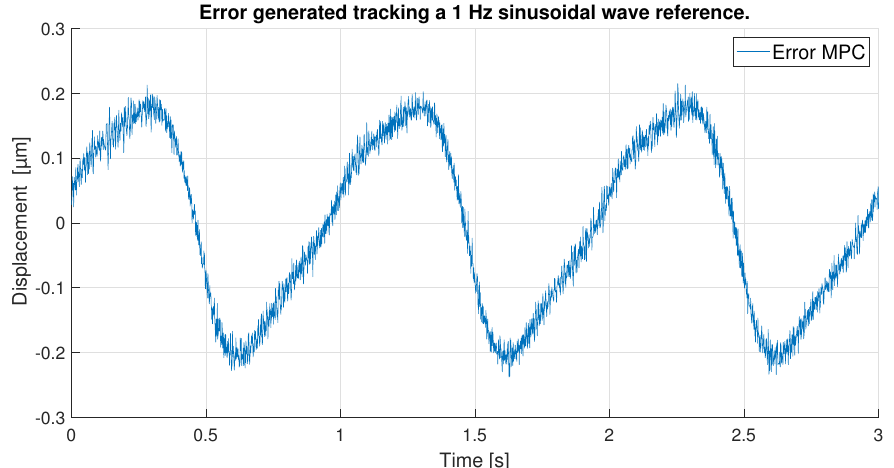
Figure 23. Error of tracking of the MPC for a 1 Hz sinusoidal